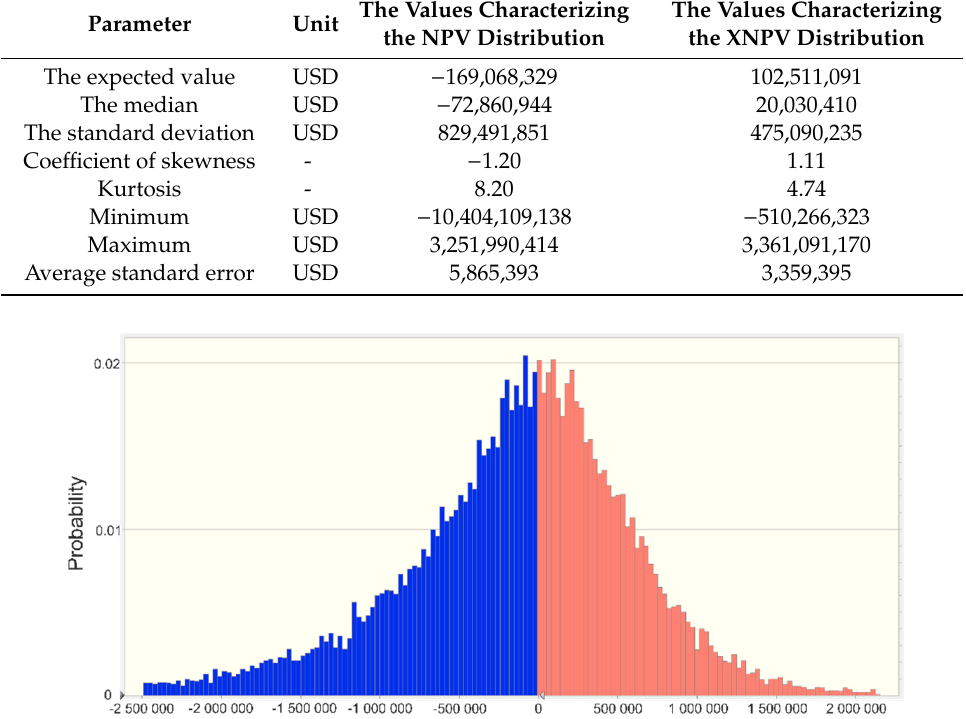
Figure 3. The distribution of the NPV in the model without options. Source: own study.